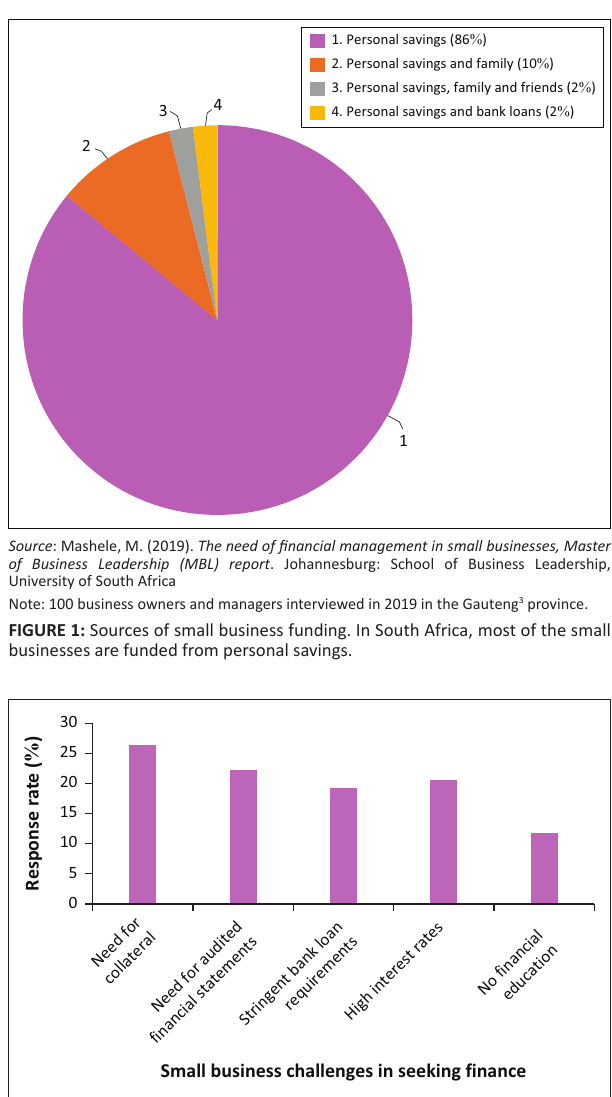
FIGURE 2 : Challenges faced by small businesses in seeking financing. In the South African market, most of the small businesses are challenged with the need of